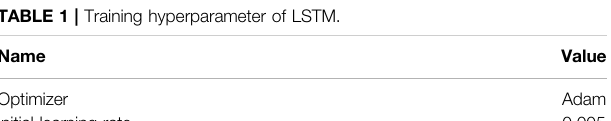
TABLE 1 | Training hyperparameter of LSTM.